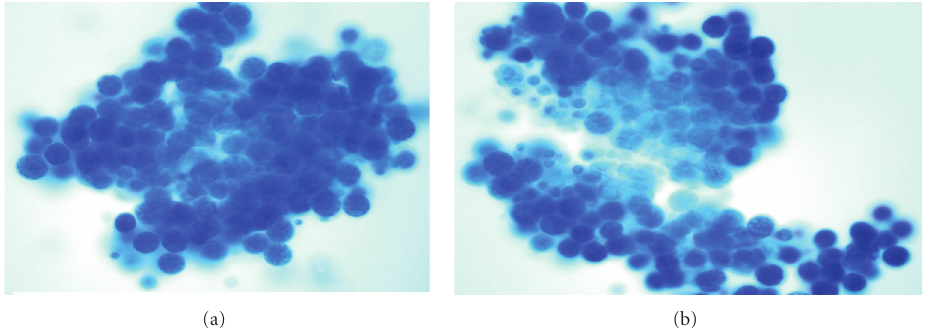
Figure 2: Yeast-like cells of variable sizes resembling endospores contained in a sporangiospore seen on a wet mount prepared using lac- tophenol cotton blue, reported as Prototheca based on the morphology of the organism. Courtesy of the Department of Pathology-Microbiology at Mount Sinai Medical Center of